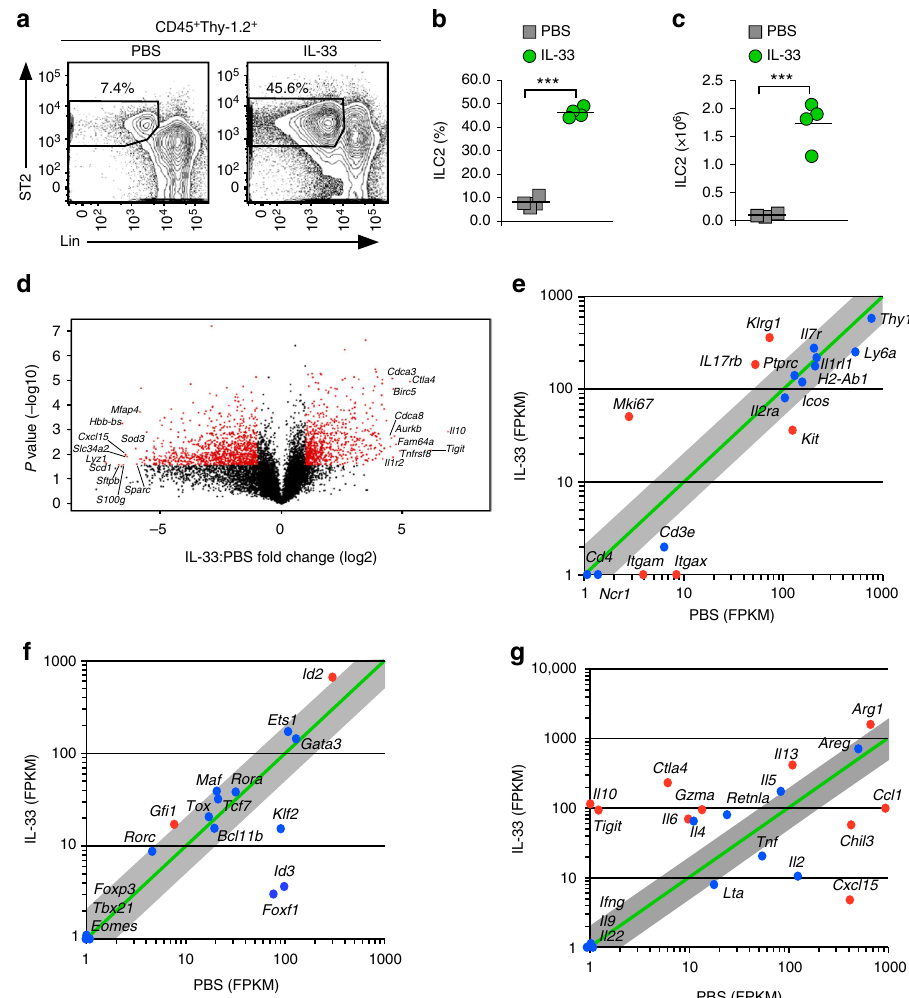
Fig. 1 In vivo activation of lung ILC2 induces Il10 expression. a Flow cytometry analysis of ILC2 from the lungs of wildtype animals treated with IL-33 (right) or PBS (left). The frequency of ILC2 (Lin – ST2 + ) within the CD45 + Thy-1.2 + cell population is indicated. b , c Frequency ( b ) and number ( c ) of lung ILC2, calculated from gates as in a, here and in all subsequent fi gures. d Volcano plot comparison of whole transcriptome gene expression of ILC2 from IL-33 and PBS-treated animals. Differentially expressed genes (de fi ned as statistically signi fi cant adjusted P < 0.05) with changes of at least twofold are shown in red (Student ’ s t test with Benjamini and Hochberg correction). The top ten differentially expressed genes ranked by fold-change in either direction are labeled. e – g Selected genes plotted as the average of the fragments per kilobase of transcript per million mapped reads (FPKM) in IL-33-treated vs. PBS-treated animals. Differentially expressed genes (de fi ned as in d ) are labeled in red. Gray area indicates region of twofold or lower change in expression. Shown are expression of selected genes grouped by ( e ) ILC2 markers and markers of activation, ( f ) transcription factors, and ( g ) effector molecules. Data are representative of four independent experiments with one mouse used per experiment a – c , or are from three experiments with cells pooled from fi ve mice each d – g . Each symbol b , c represents an individual mouse and horizontal lines indicate the mean here, and in all subsequent fi gures. ***P <